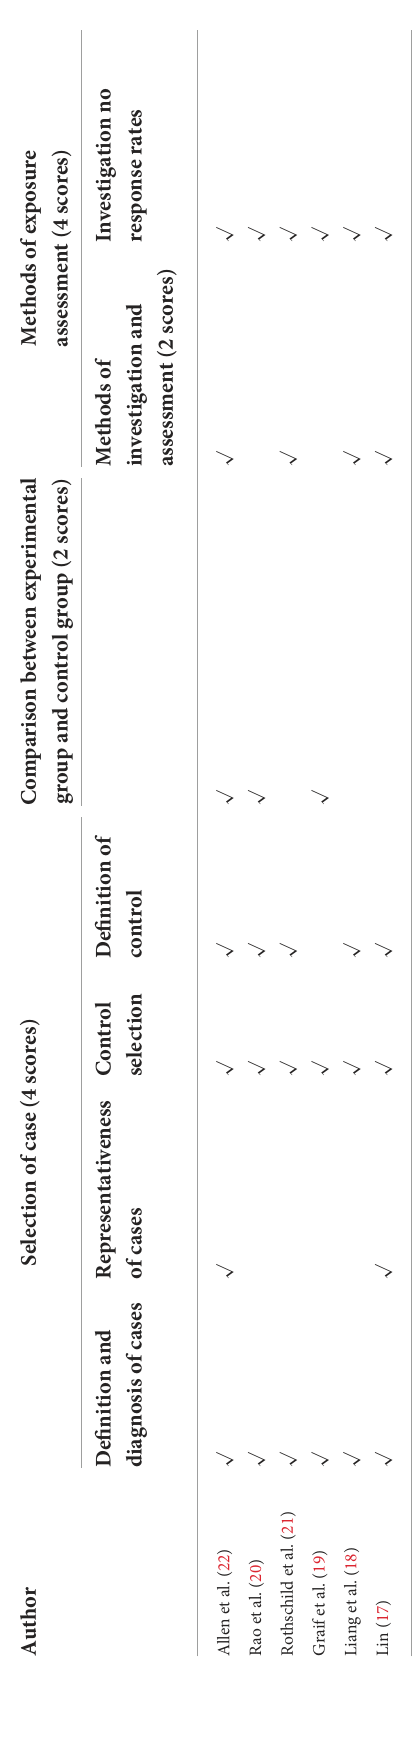
for the RCT, while NOS scales were applied for the non- randomized controlled studies to evaluate the quality of the covered literature. The quality evaluation of the RCT trial literature reflected high quality. The Newcastle-Ottawa Scale (NOS) evaluation results of the non-randomized controlled study were discussed in Table 2, and three studies are six points, and another three studies are five, seven and eight √ √ √ points, respectively.